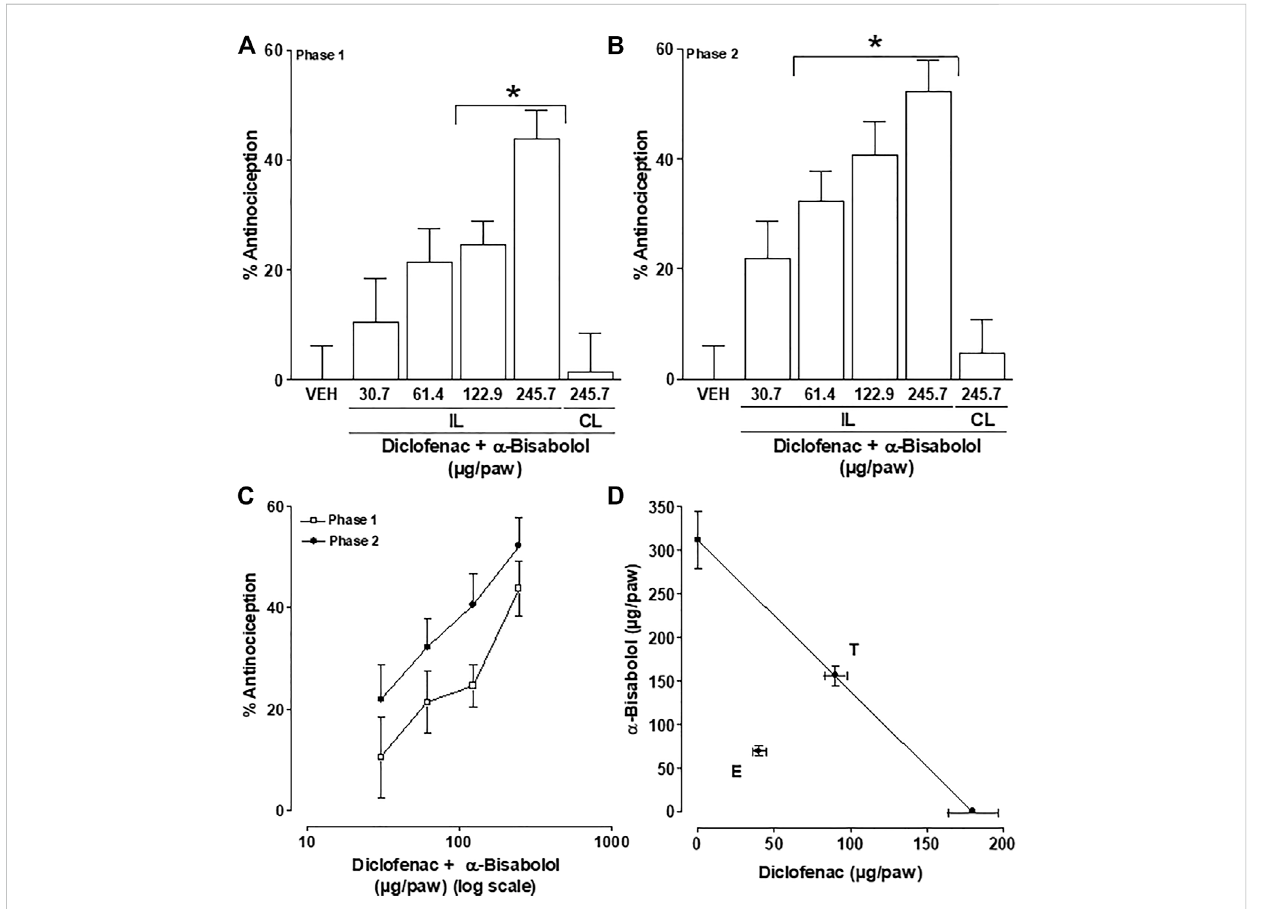
FIGURE 2 Drug interaction study: Local peripheral antinociception of the α -Bisabolol-diclofenac combination on the phase one (A) and phase two (B) of the formalin test; rats were pretreated with the local injections of vehicle (VEH) or α -Bisabolol-diclofenac combinations before formalin injection. Data from (A,B) arepresentedinsigmoidcurvesin (C) (logscales). (D) Isobologramshowingthelocalinteractionbetween α -Bisabololanddiclofenaconthesecond phase of the formalin test. The oblique line between the x and y -axes is the theoretical additive line. The point in the middle of this line, indicated by “ T ” ,isthetheoreticaladditive pointcalculatedfromtheindividualdrugEDvalues.Theexperimentalpoint indicatedby “ E ” , istheactualobserved EDvalue for this combination. Horizontal and vertical bars indicate